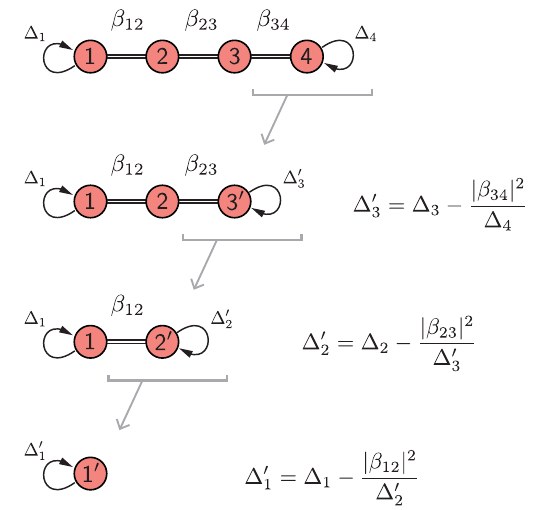
FIG. 7. Graph reduction of a four-mode circuit with nearest- neighbor connectivity, where couplings are either passive or via parametric frequency conversion